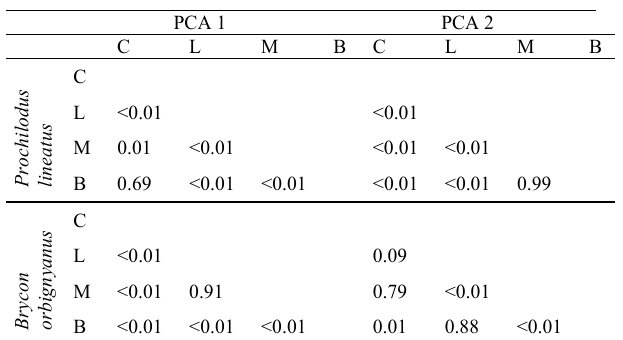
Table 3. Results of the Tukey’s test for the treatments [C = control; L = logs; M = macrophytes; and B = both (logs+macrophytes)] of Prochilodus lineatus and Brycon orbignyanus from the first two axes of the Principal Component